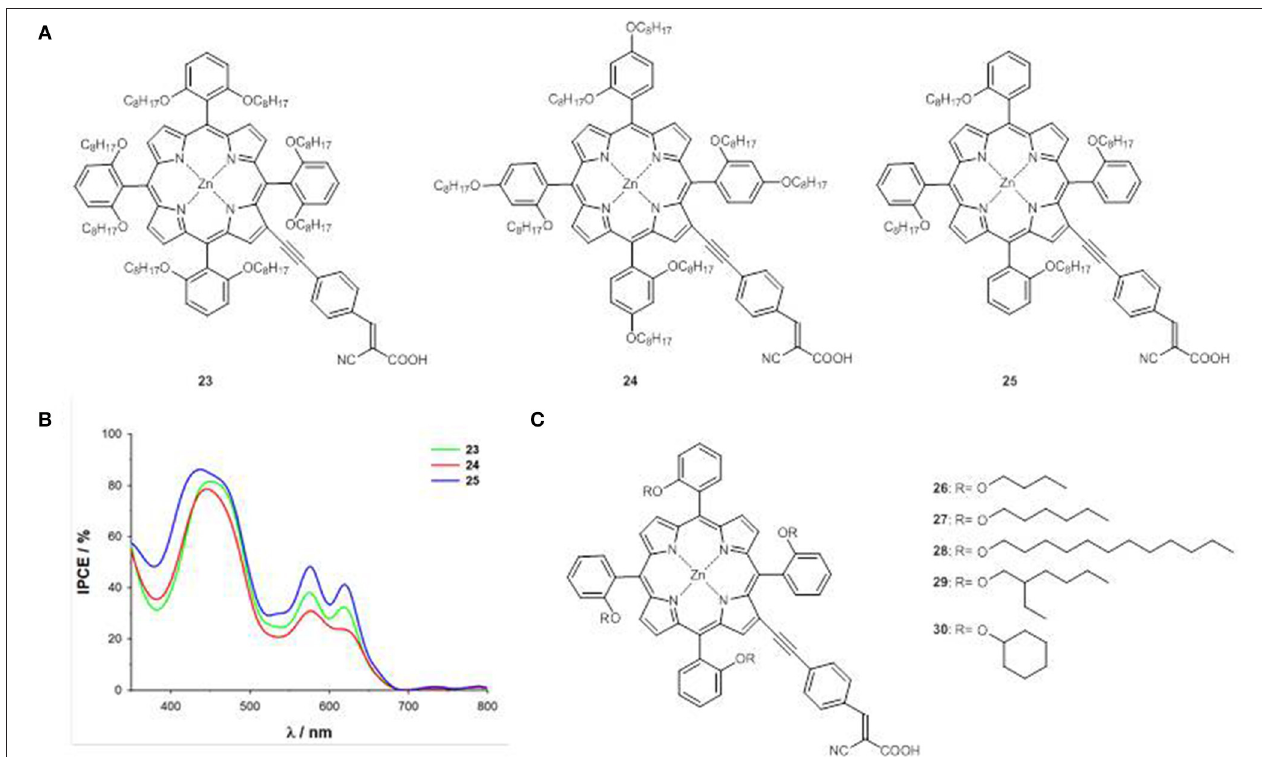
FIGURE 12 | (A) A 4 β -pyrrolic Zn II porphyrins 23-25 ; (B) IPCE spectra of 23-25 ; (C) A 4 β -pyrrolic Zn II porphyrins 26-30